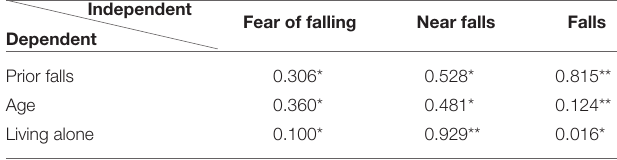
TABLE 3 | Sociodemographic baseline variables of pilot-test participants. TABLE 5 | Statistical analysis in both groups using t -test (R s ).